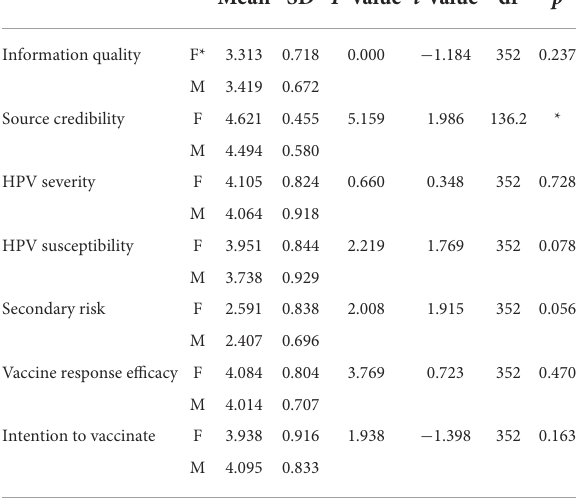
TABLE 1 Descriptive statistics and independent samples t